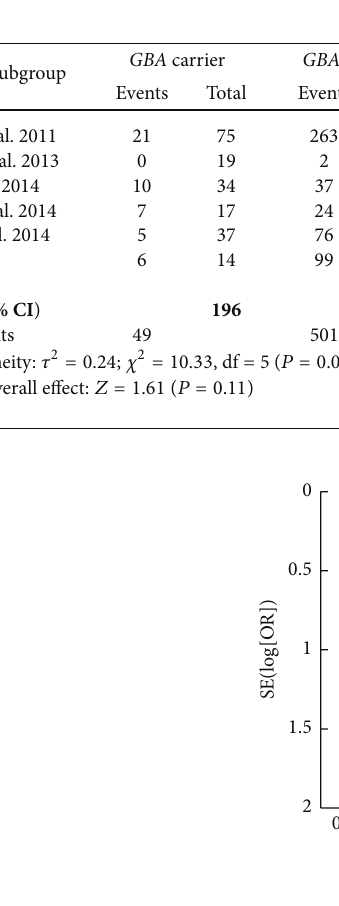
Figure 7: (a) Forest plot of dyskinesia in GBA + PD and GBA − PD. (b) Funnel plot of dyskinesia in GBA + PD and GBA − PD.